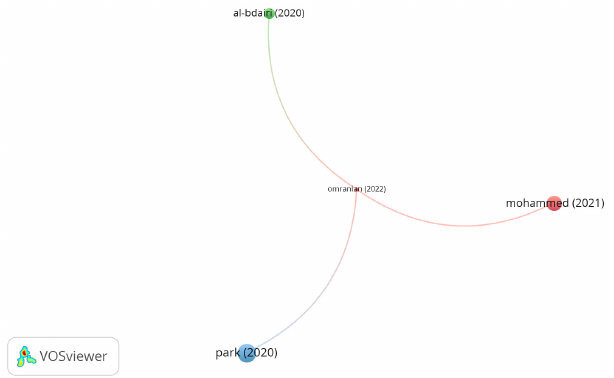
Figure 1. Annual publications.